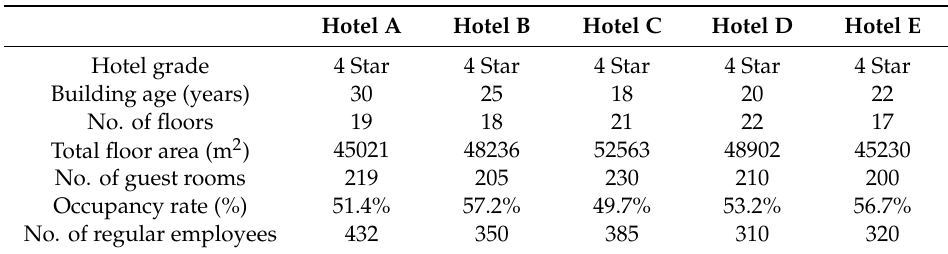
Table 3. Characteristics of the